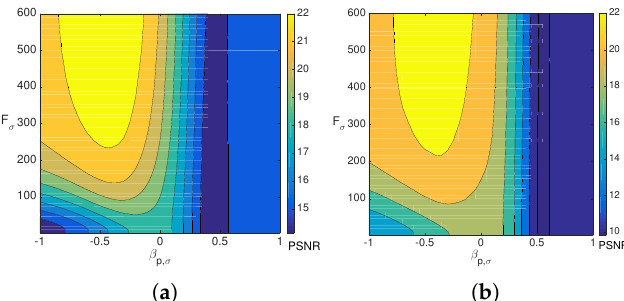
Figure 5. Surface plots of the dependency of the PSNR measure on F σ and β p , σ . Images corrupted by Gaussian σ = 30 and impulse p = 0.3. ( a ) Flower. ( b )